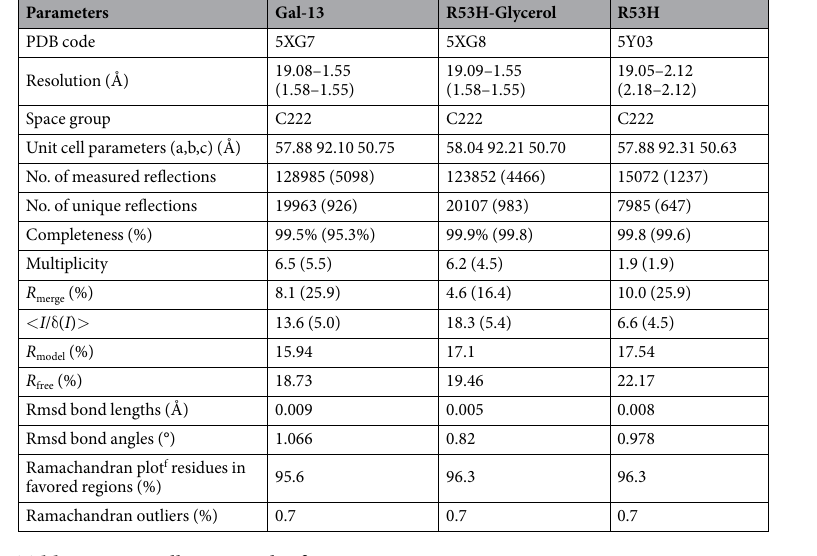
Table 1. Data collection and refinement